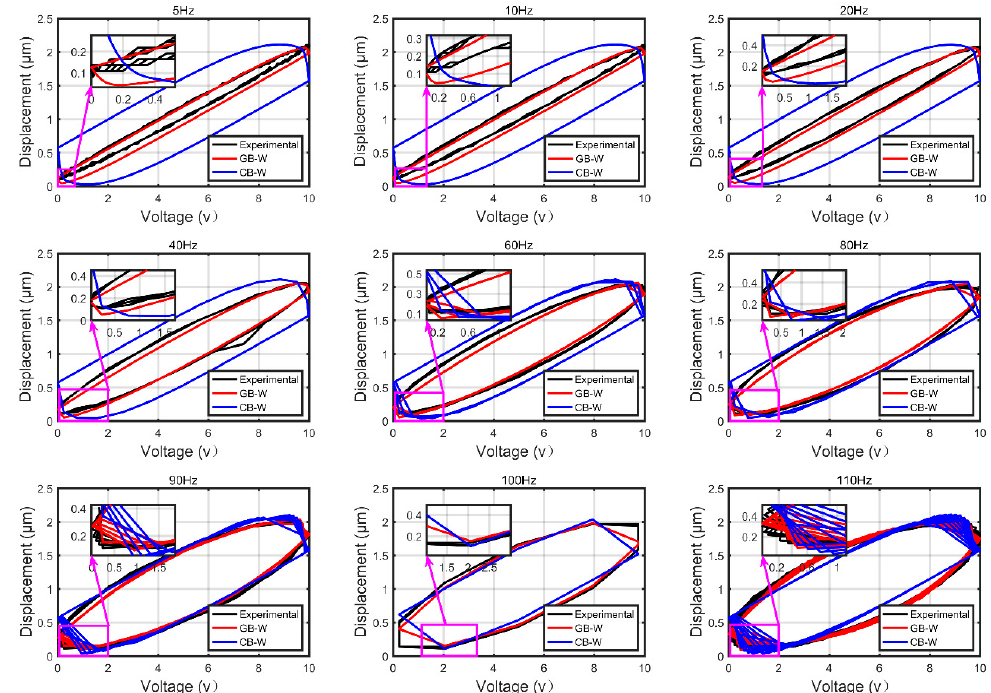
Figure 8. Comparisons of the measured and simulation results predicted by the GB–W model and classical CB–W model.